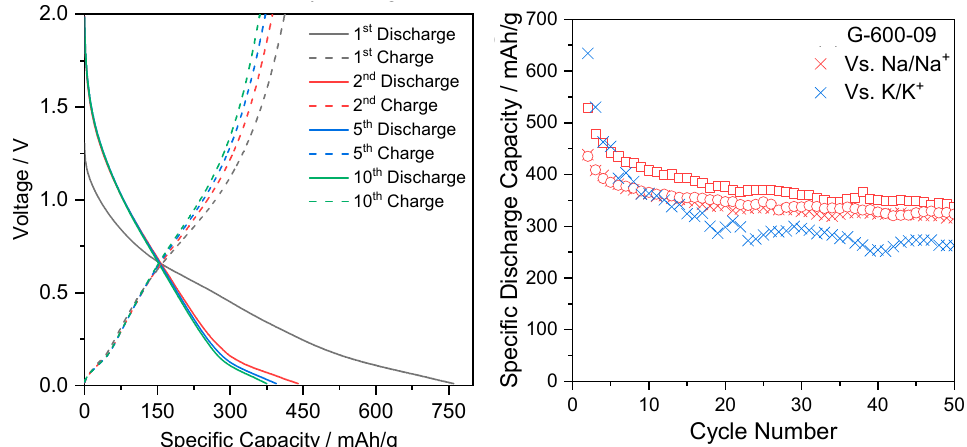
Figure 3. Electrochemical performance summary of selected cells, with the 1st discharge and charge capacities when cycled at 10 mA/g against Na/Na+, and the initial coulombic efficiency of the 1st charge cycle (striped bars).